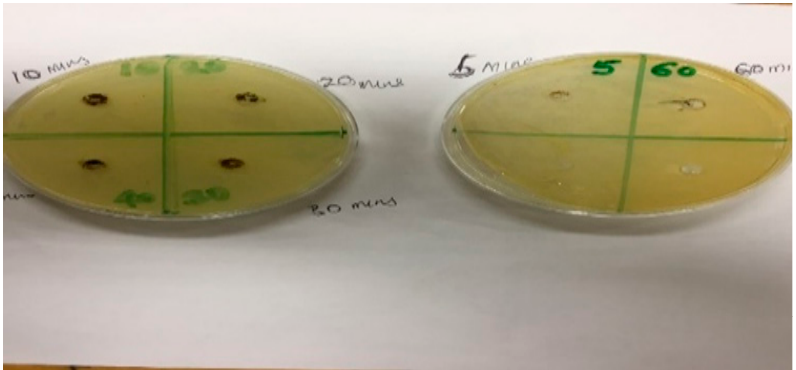
Figure 8. Pictorial view of the plates showing mixtures of E . coli strains and activated clay samples in the six bored holes.